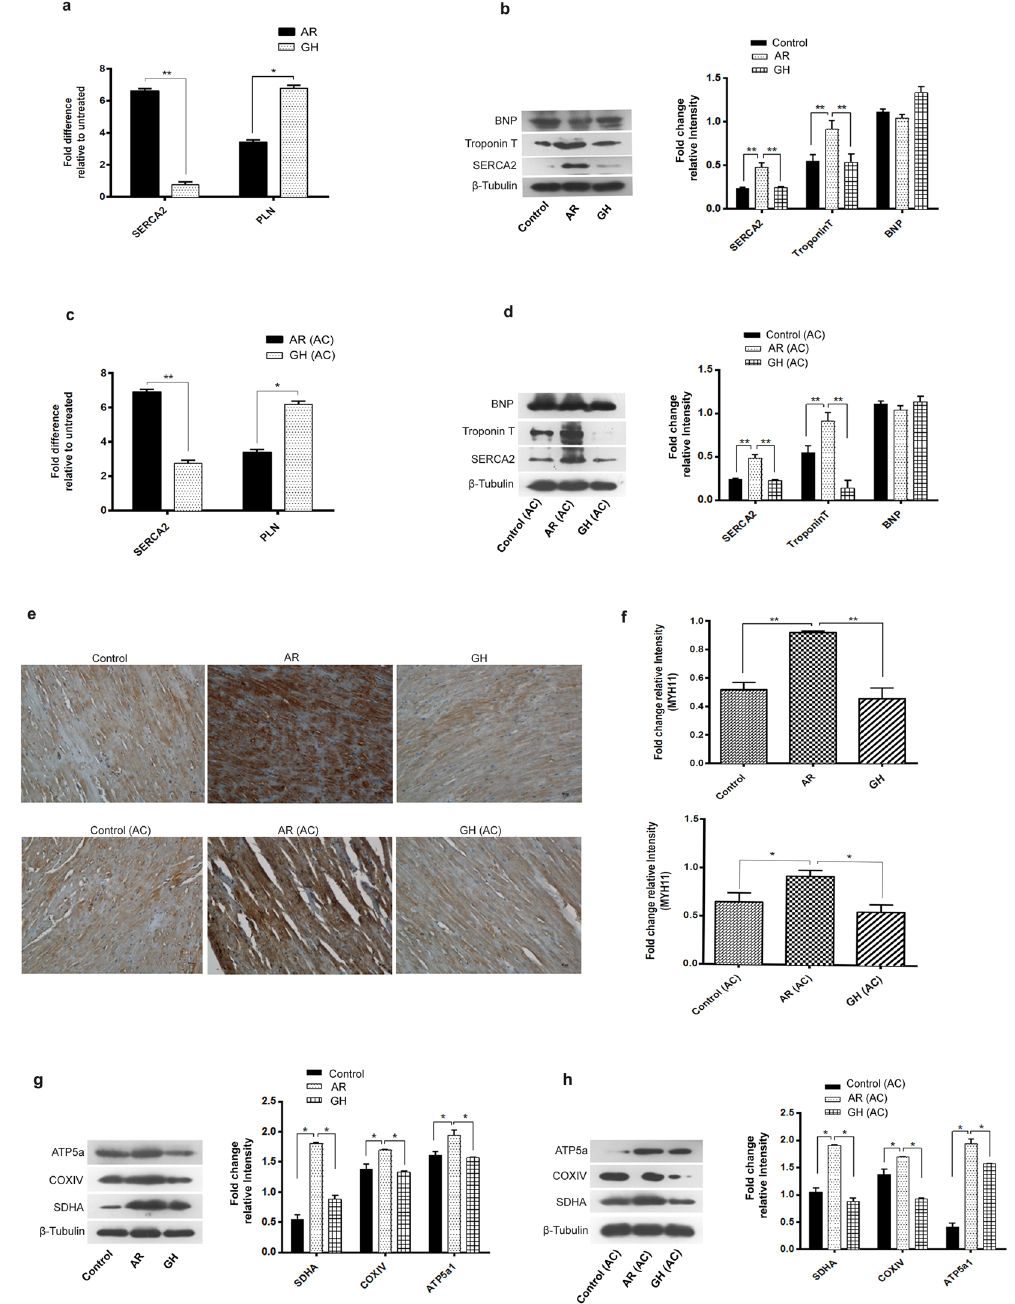
Figure 4. AR improved muscle contraction and mitochondrial bioenergetics function in aging and AC group of rats. ( a , c ) qRT-PCR analysis revealed an increase in mRNA expression of SERCA2 and decrease in PLN genes respectively in both aging and aorta constricted (AC) group of rats. ( b , d ) Representative immunoblots of BNP, troponinT, SERCA2a and β -tubulin from heart of rats and densitometry analysis revealed significant increase in expression of marker proteins which regulate the muscle contraction in both aging and aorta constricted (AC) group of rats. ( e ) Representative immunohistochemistry images of cross sections of hearts which were immunostained with Myh11 antibody (20X). ( f ) Quantification of immunostained myocardium revealed the increase in Myh11 expression in AR administered rats when compared with GH or control groups. ( g , h ) Representative immunoblots of ATP5a, COXIV, SDHA and β -tubulin from heart of rats and densitometry analysis revealed significant increase in expression of marker proteins which regulate the mitochondrial OXPHOS function, in both aging and aorta constricted (AC) group of rats. β -tubulin was used as loading control. Values represent the mean ± s.e.m. of data from 6 rats in each group. * P < 0.05, ** P < 0.01 (AR versus GH or control; AR (AC) versus GH (AC) or control (AC) groups), results were analyzed by 2-way ANOVA followed by multiple comparisons with Tukey’s